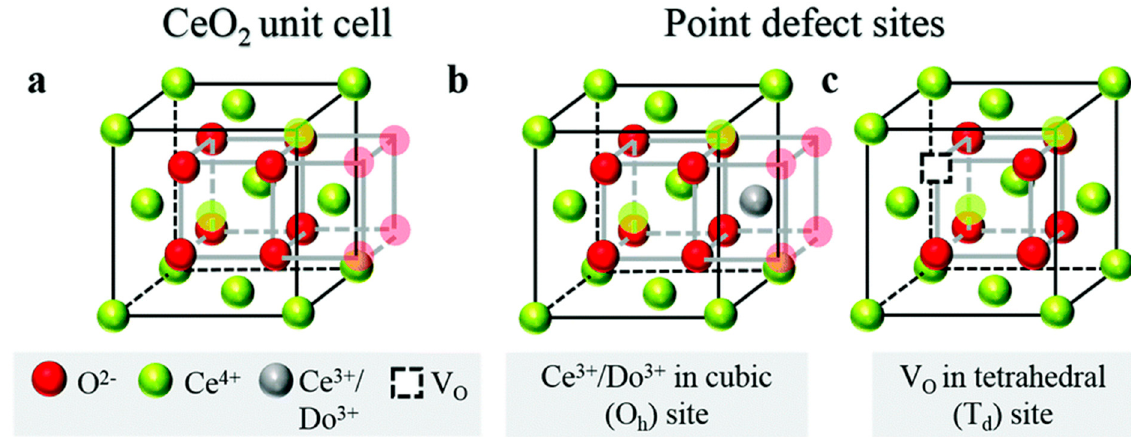
Figure 1. Schematic of crystal structure and defects for ceria and substituted variant [20]. ( a ) The fluorite ceria unit cell, containing 8 oxygen atoms (red) forming a simple cube embedded inside a face-centred cubic (FCC) array of Ce cations (green). Every second oxygen cube contains a Ce cation, as illustrated by the 4 semi-transparent oxygen atoms on the right, belonging to the next unit cell. Overall, the fluorite unit cell has 8 oxygen atoms and 4 cerium atoms. ( b , c ) Illustration of the two main point defects which may or may not be preferentially nearest neighbours, depending on the dopant type and prevalence of oxygen deficiency. Cation defects, Ce 3+ (in oxygen-deficient ceria) and Do 3+ (in substituted ceria), sit in a Ce 4+ cubic site of Oh symmetry with 8-fold oxygen coordination. Every two cation defects in the structure are balanced by one oxygen vacancy defect, V O , which sits in a tetrahedral site of Td symmetry, with 4-fold cation coordination. Reproduced from Schmitt, R.; Nenning, A.; Kraynis, O.; Korobko, R.; Frenkel, A.I.; Lubomirsky, I.; Haile, S.M.; Rupp, J.L.M. A review of defect structure and chemistry in ceria and its solid solutions. Chem. Soc. Rev. 2020 , 49 , 554–592, Published by The Royal Society of Chemistry [20].